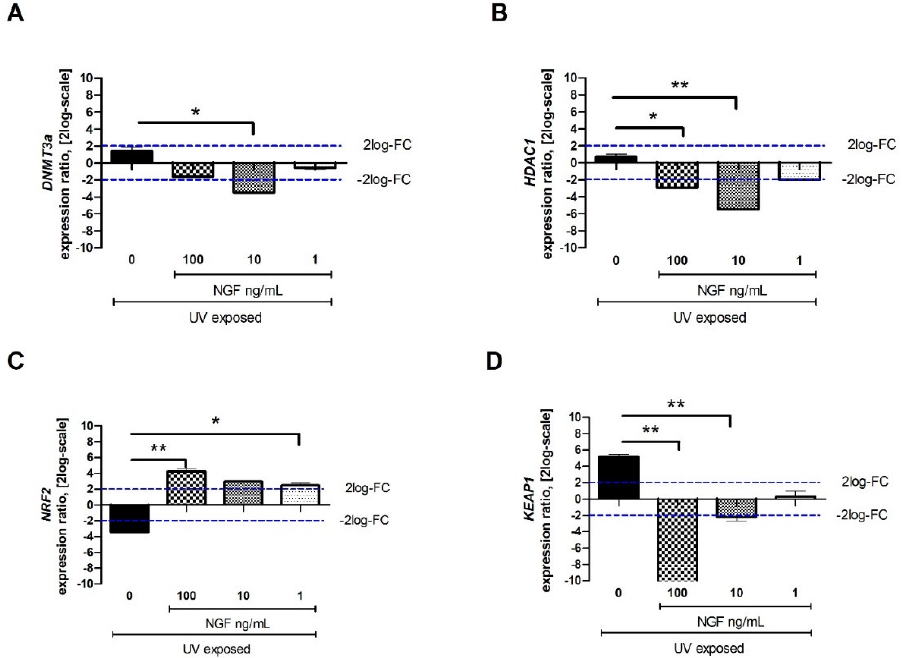
Figure 4. Effect of NGF supplementation on specific tissue remodeling-associated epigenetic targets. Starved monolayers were UV-exposed either alone (0.05% FBS medium) or supplemented with increasing NGF doses (1 – 10 – 100 ng/mL). After specific exposure, conditioned media were collected, and monolayers were extracted for total RNA analysis. UV exposure resulted in slight transcripts for DNMT3a ( A ), no transcript modulation for HDAC1 ( B ), low transcripts for NRF2 and high transcripts for KEAP1 ( D ). NGF supplementation (1 – 10 – 100 ng/mL) downregulated the expression of DNMT3a ( A ), HDAC1 ( B ), and KEAP1 ( D ) at all concentrations tested. NRF2 upregulation was significant at all NGF doses ( C ). Data represent mean expression ratio ± SEM (fold changes as 2log-scale). REST analysis followed by ANOVA—Tukey–Kramer post hoc analysis defined significant transcript changes as indicated in the graphics (* p < 0.05 and ** p < 0.01, with respect to UV exposure); blue dashed lines pointing at 2log-FC biological relevant limit.